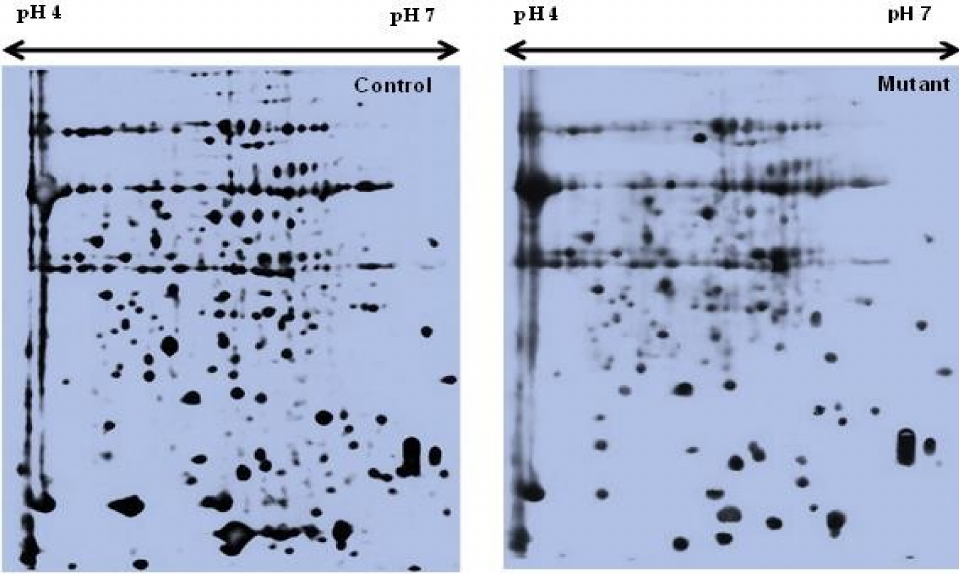
Figure 1. Representative 2-DE profiles of the leaf proteins of Nigella sativa L. Table 2. Total number of the leaf protein spots of Nigella sativa L. S.N.